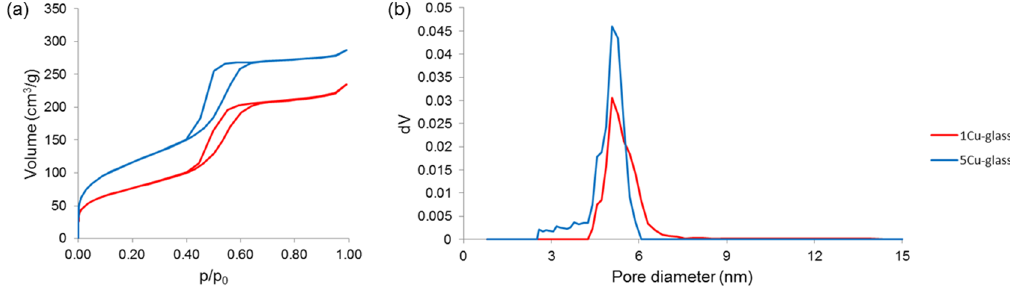
Figure 5. Nitrogen adsorption-desorption measurements performed on calcined glasses: ( a ) isotherms and ( b ) pore size distributions. Table 1. Textural characteristics of calcined mesoporous glasses obtained by nitrogen adsorption-desorption